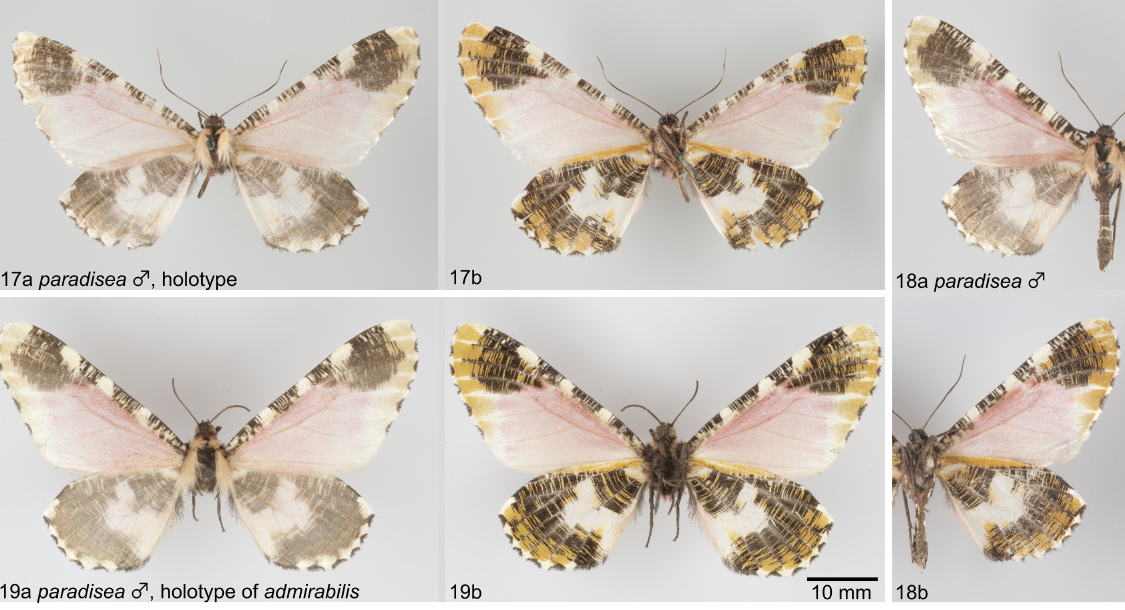
Figs 17–19. Adult moths, ♂♂ (a = dorsal view; b = ventral view). 17 . Callipia paradisea Thierry-Mieg, 1904, holotype (C-0194). 18 . C. paradisea Thierry-Mieg, 1904 (C-0195). 19 . C. paradisea Thierry- Mieg, 1904 (holotype of C. admirabils Warren, 1904)